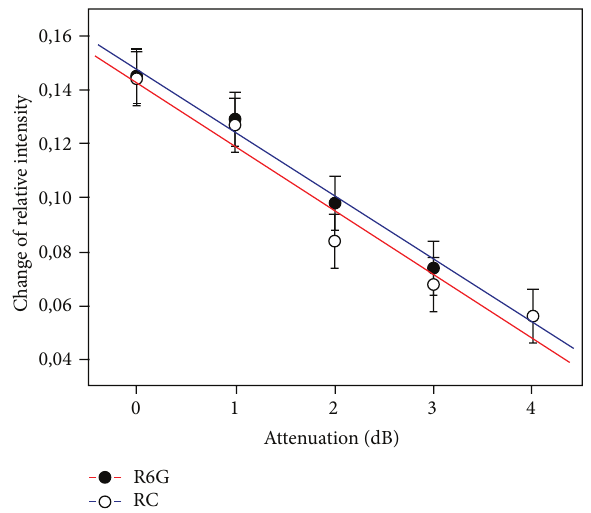
Figure 6: Change of relative fluorescence intensity of the relaxation factor of